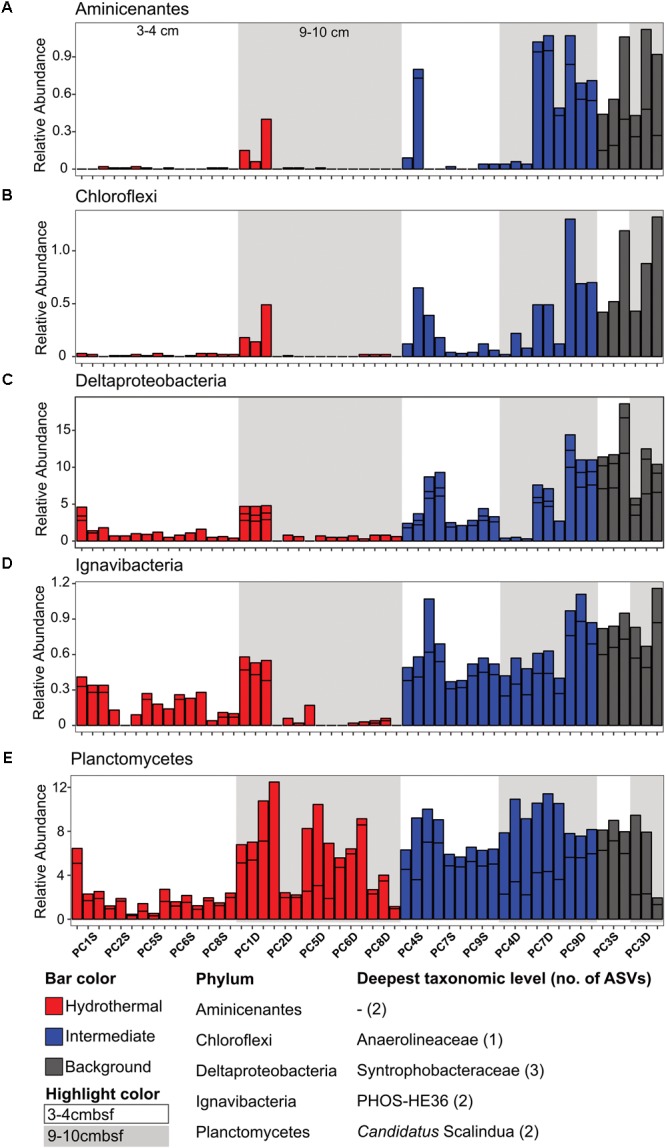
Select ASVs associated with (A) Aminicenantes, (B) Chloroflexi, (C) Deltaproteobacteria, (D) Ignavibacteria, and (E) Planctomycetes which were more abundant in the background and/or the background plus intermediate samples. Bars are colored by sample, and divided by ASV abundance. Relative abundance is in percent of total sequences per sample. The deepest taxonomic level assigned are listed next to the phylum followed by the number of ASVs graphed.